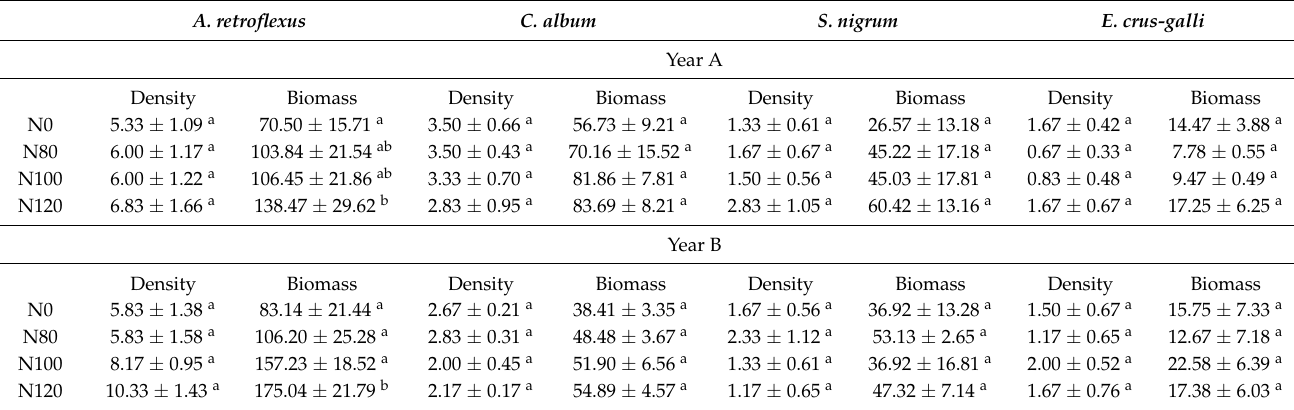
Table 6. The average density (plants m − 2 ) and biomass (g m − 2 ) of each major weed species per